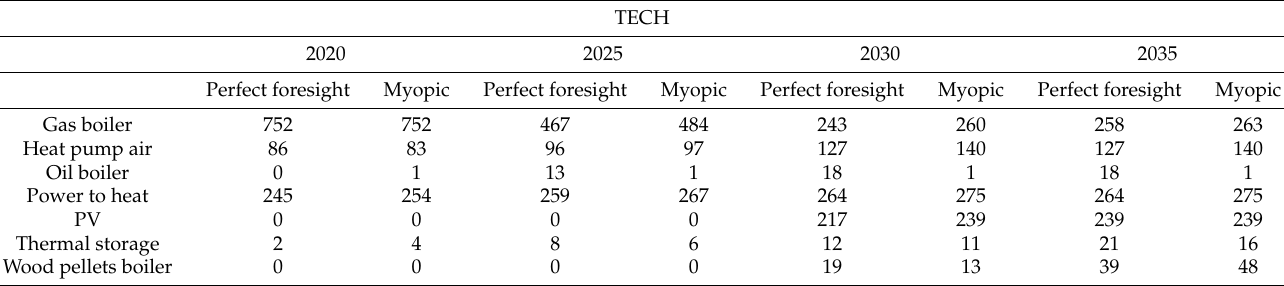
Table 4. Installed generation capacities in all